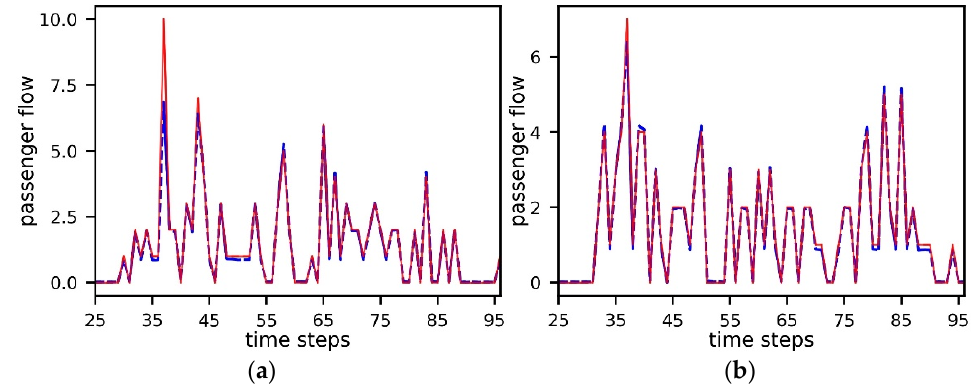
Figure 9. The examples of forecasting curves and the ground-truth curves for residential to suburban OD flow: ( a ) weekdays; ( b ) weekends.